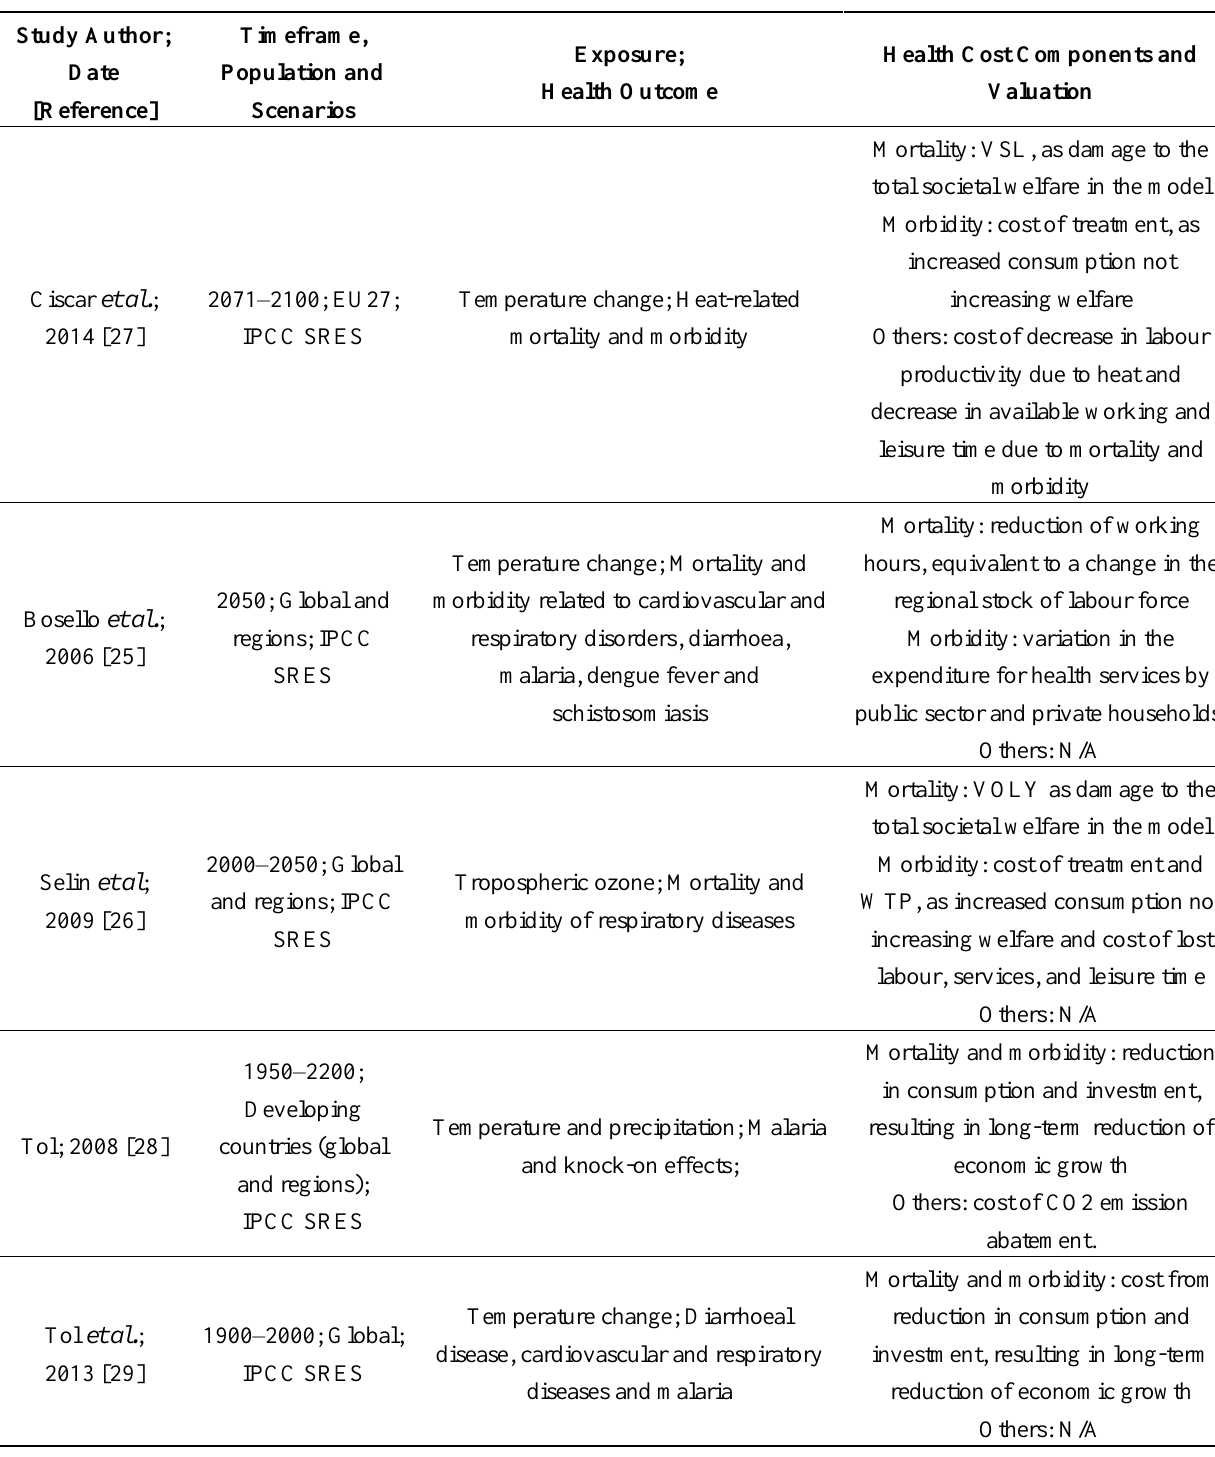
Table 2. Studies estimating economy-wide impacts of health damage from climate